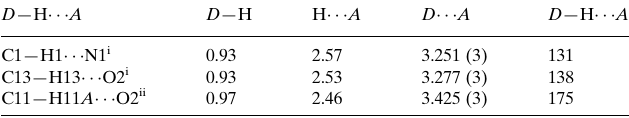
Hydrogen-bond geometry (A˚ , (cid:2)